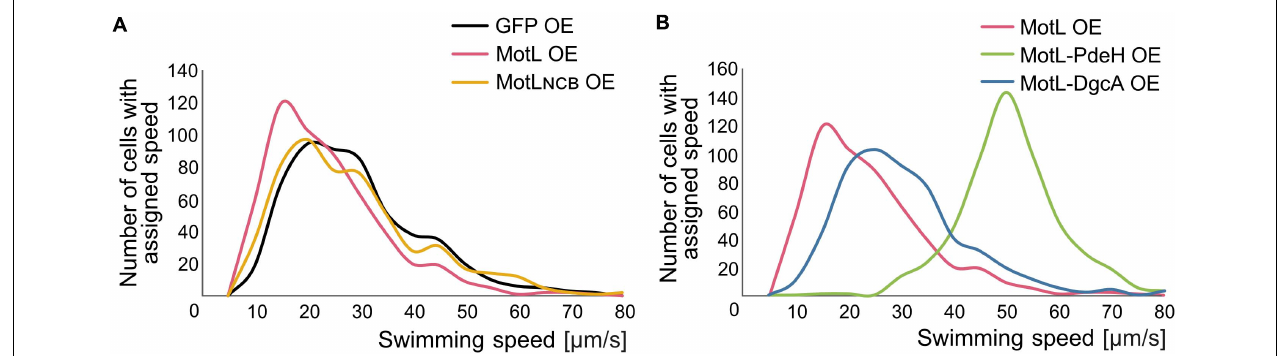
FIGURE 4 | MotL affects the swimming speed mediated by the lateral flagella in a c-di-GMP-dependent fashion. (A) Effect of an OE of MotL (red), MotL NCB , and GFP (control) on the swimming speed of a strain only possessing the lateral flagella ( (cid:49) P). (B) Effect of an OE of MotL alone (red) or in concert with the phosphodiesterase PdeH (green) or the diguanylate cyclase DgcA (blue). For both (A,B) the swimming speeds of 591 cells per strain were analyzed. See also Supplementary Figure 3 for the statistical